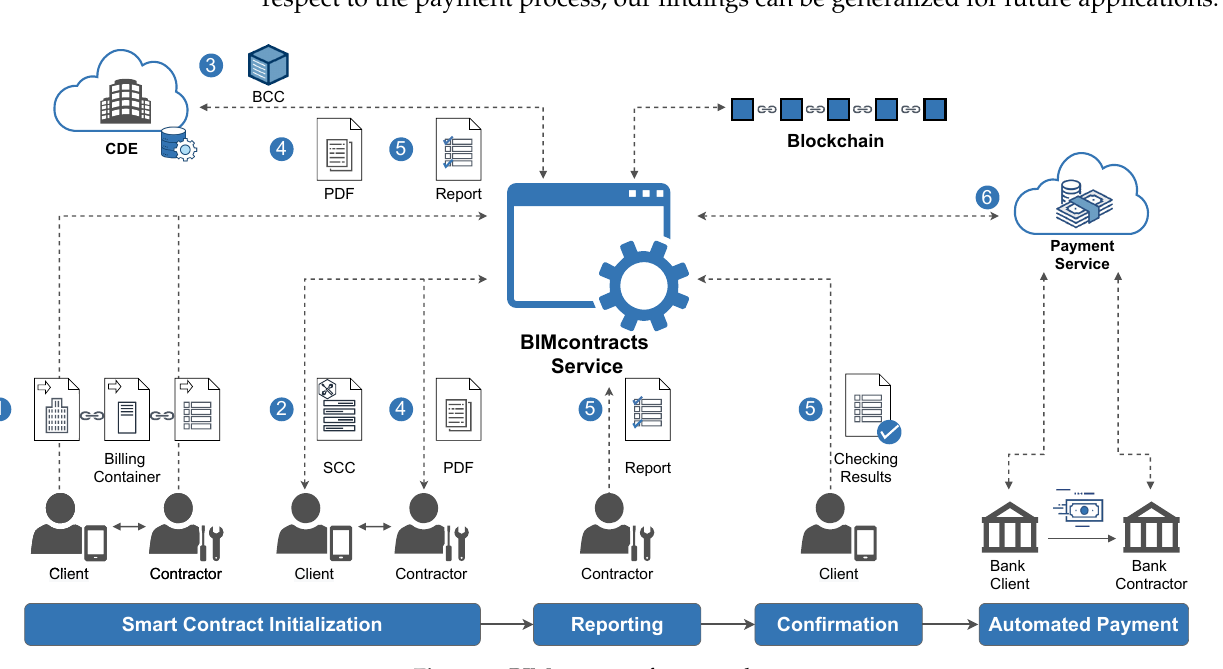
Figure 1. BIMcontracts